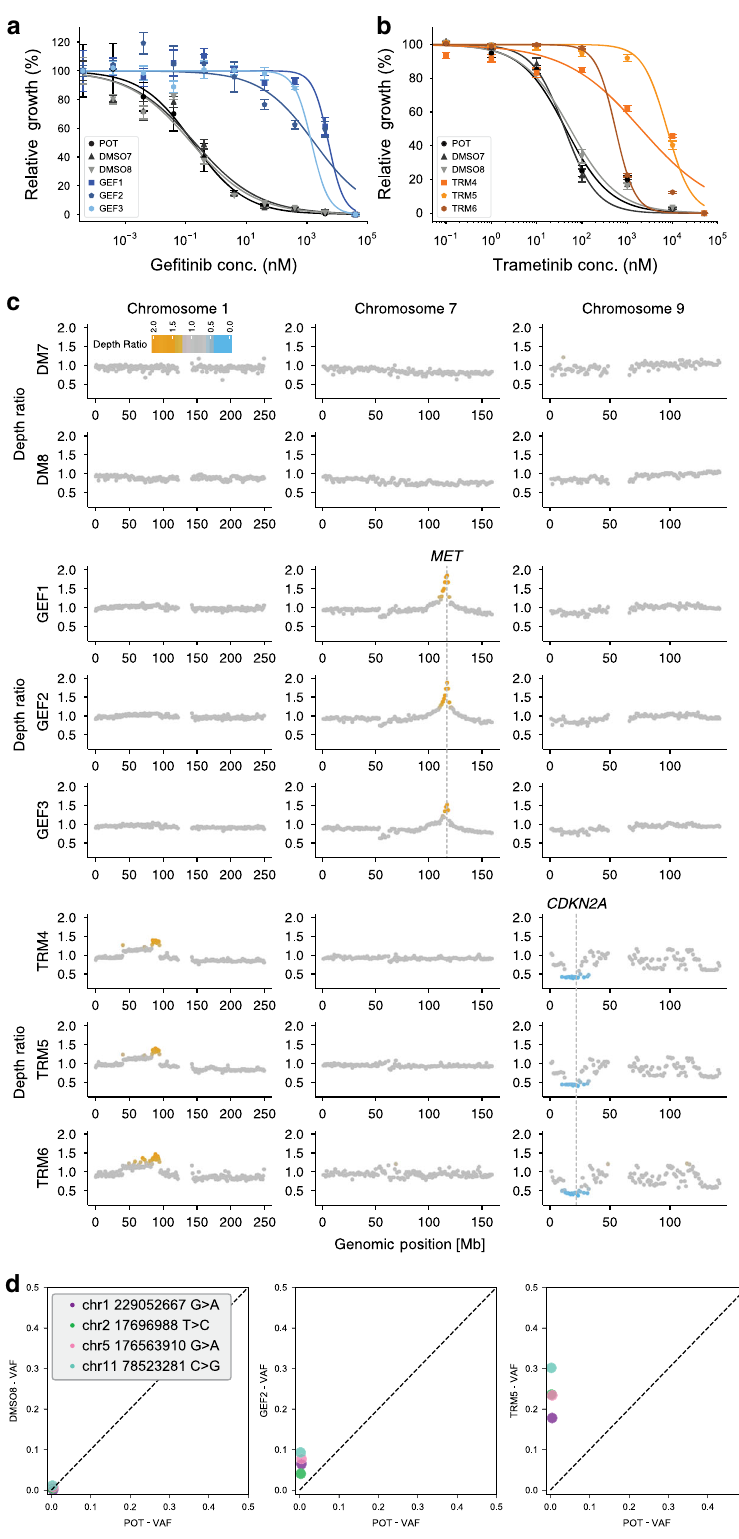
Fig. 3 Characterisation of resistant lines. a Dose – response curves of ge fi tinib-resistant lines and b trametinib-resistant lines versus DMSO demonstrate acquired resistance. Error bars of dose – response curves represent SEM. c Relative copy number pro fi les of resistant lines compared to POT highlight MET ampli fi cation in GEF lines and 1p gain, 9p loss (including CDKN2A ) in TRM lines. d Single-nucleotide variant analysis shows enrichment of a subclone containing four variants in TRM and partial enrichment in GEF of the same clone (VAF variant allele